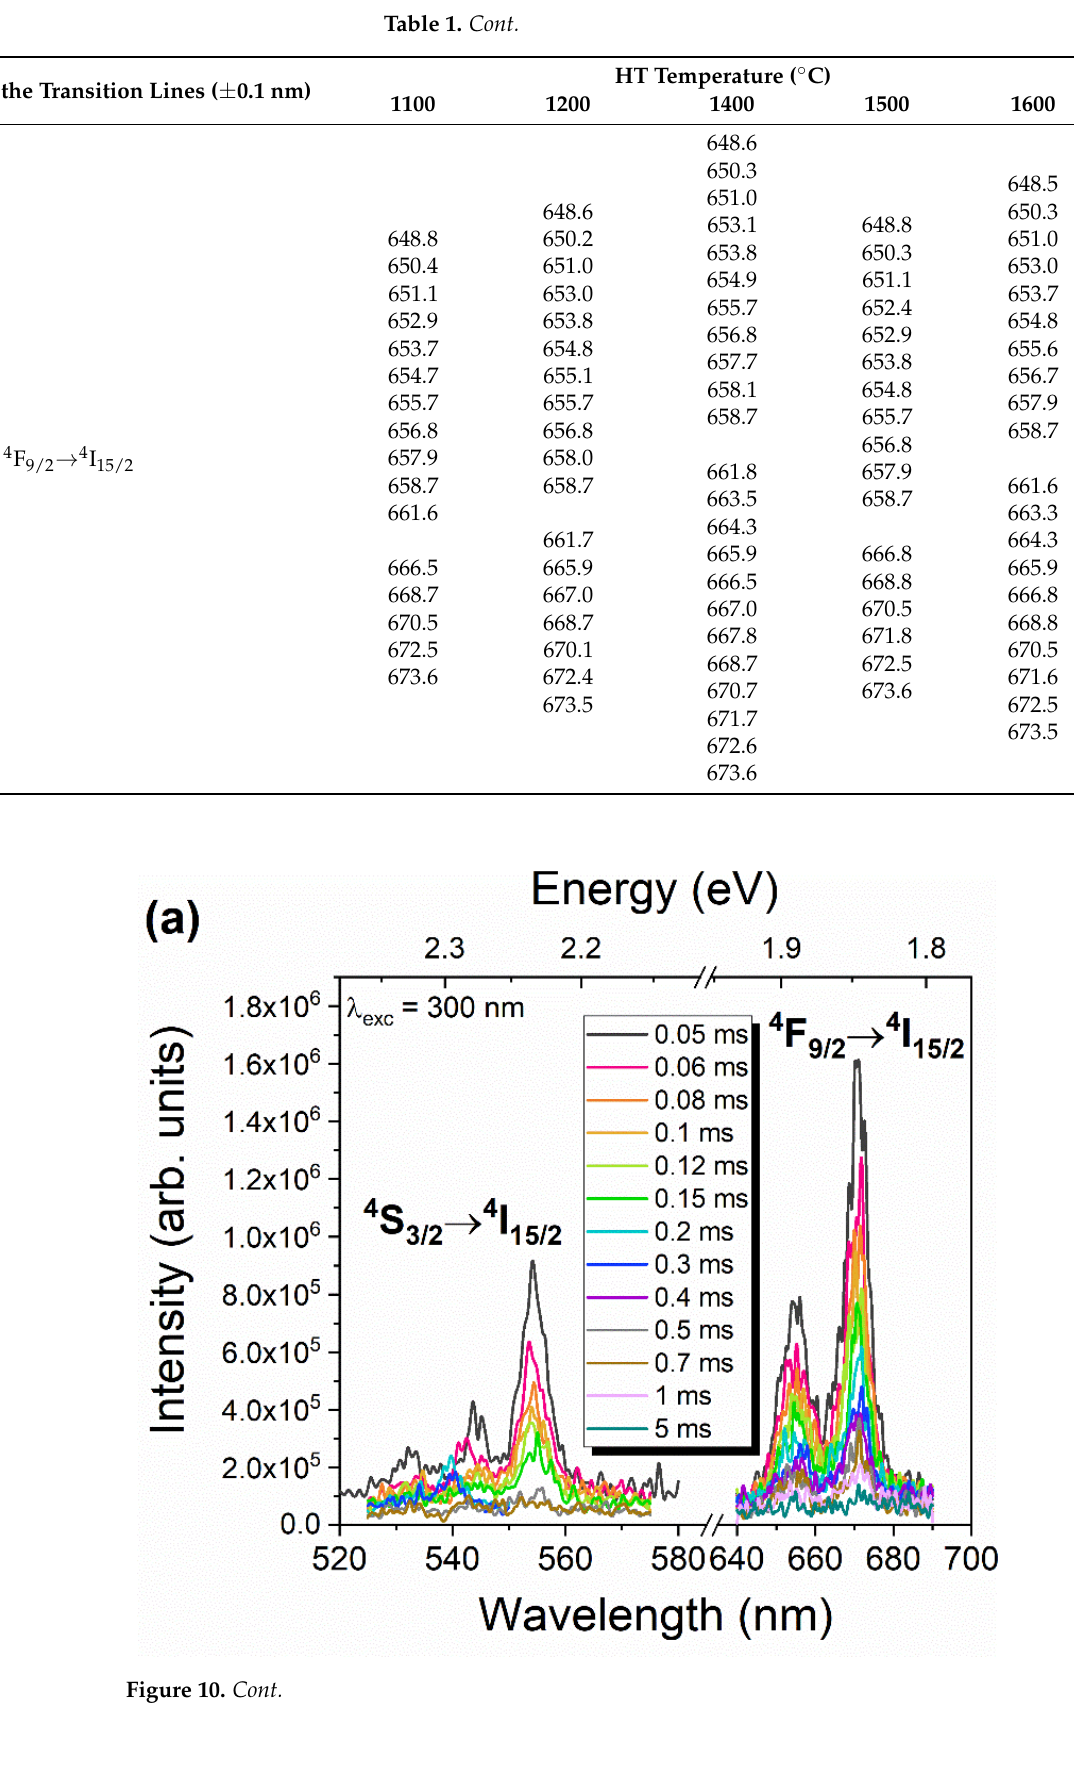
Figure 10. TRPL spectra obtained for the HT1200 sample under two excitations: ( a ) 300 nm; ( b ) 379 nm.